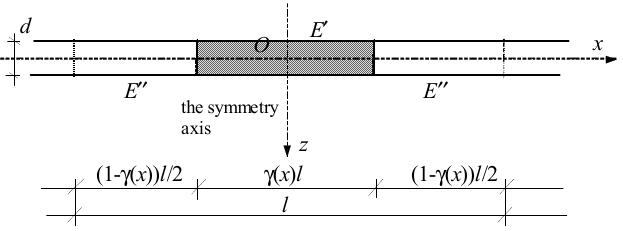
Figure 3. A cell of the microstructured functionally graded plate band.